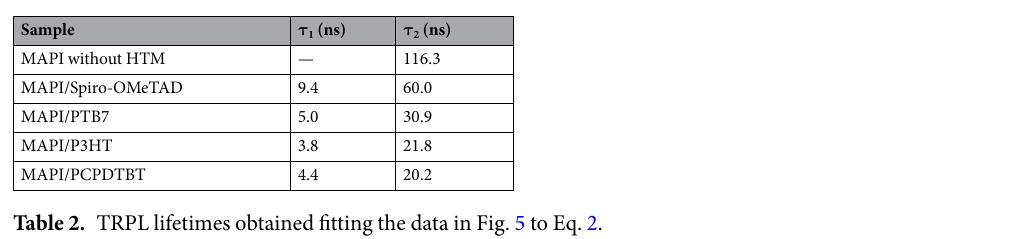
Table 2. TRPL lifetimes obtained fitting the data in Fig. 5 to Eq.